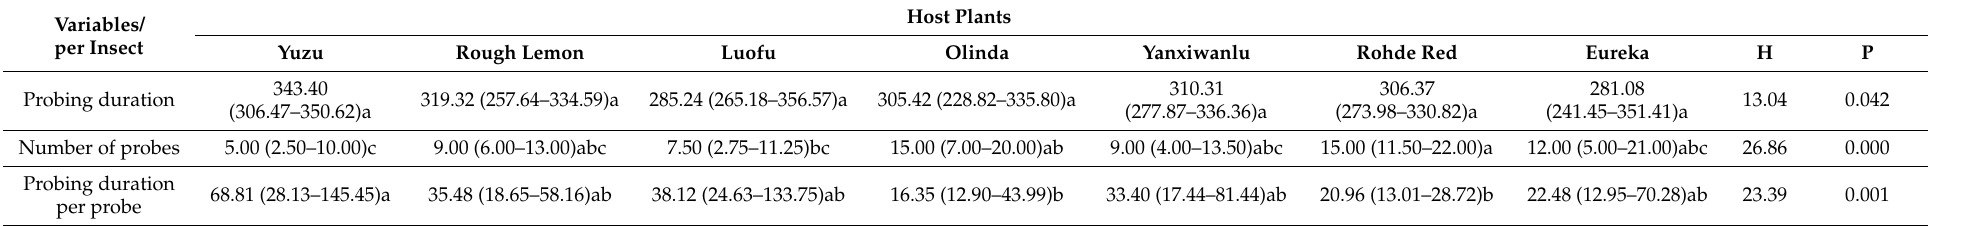
Table 1. The durations (min) and counts of probing variables recorded using an EPG study of Toxoptera citricida on seven host plants.